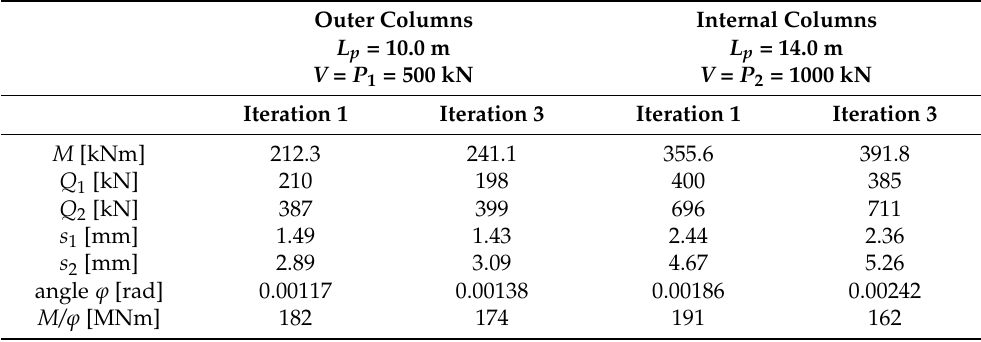
Table 2. Results of the pile settlement calculations in the column supports; Example 1.